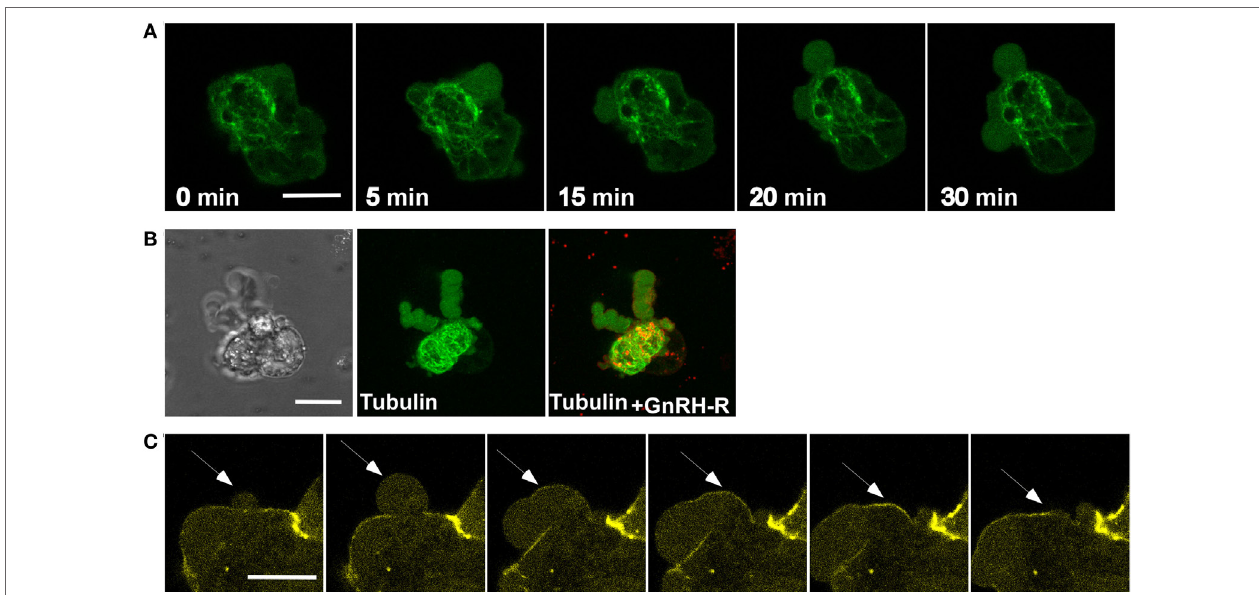
FigUre 7 | Tubulin and actin, but not microtubules, are present in the blebs . (a) Images from a confocal microscopy time-lapse movie of serum-starved L β T2 cells transfected with GnRH receptor (GnRHR)-mCherry and EMTB-3XGFP (the microtubule-binding domain of ensconsin (EMTB) fused to three GFP molecules, allowing microtubules visualization) and treated with GnRH (30 min, 10 nM). Bleb formation was noticed, while microtubules are not present in the blebs. The scale bar is 10 µm. (B) Blebs images after GnRH treatment, including DIC and fluorescent images of GnRHR-mCherry and EMTB-3XGFP, supporting the data observed in panel (a) . The scale bar is 10 µm. (c) Actin is involved in bleb retraction. Addition of GnRH (30 min, 10 nM) to serum-starved L β T2 cells transfected with actin-YFP resulted in bleb formation. Actin is recruited to the blebs after they are stabilized and is best observed during blebs retraction (see arrows). The scale bar is 10